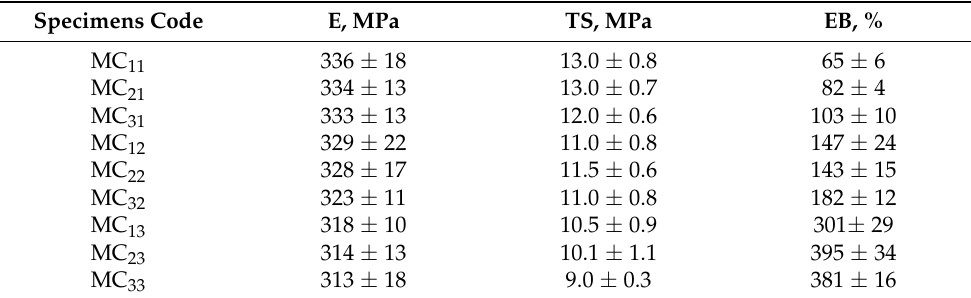
Table 4. Elastic modulus, E, tensile strength, TS, elongation at break, EB, of all the